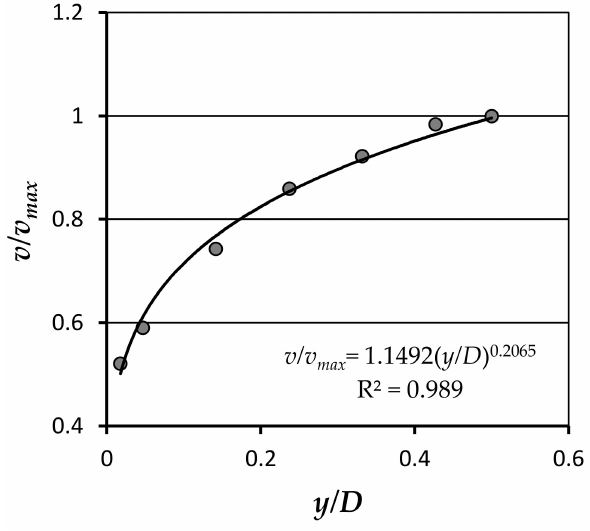
Figure 4. Velocity profile measured for the sand mixture, with D m = 0.30 mm and a sand concentration of 0.054, and the power velocity profile having Equation (4) with δ = 0.2065.